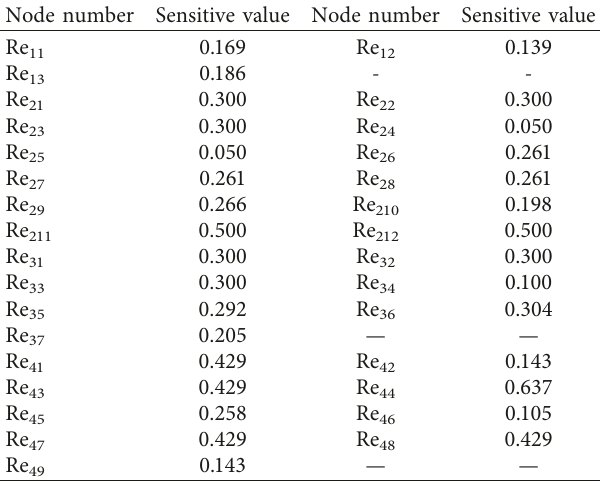
Table 9: Sensitivity analysis